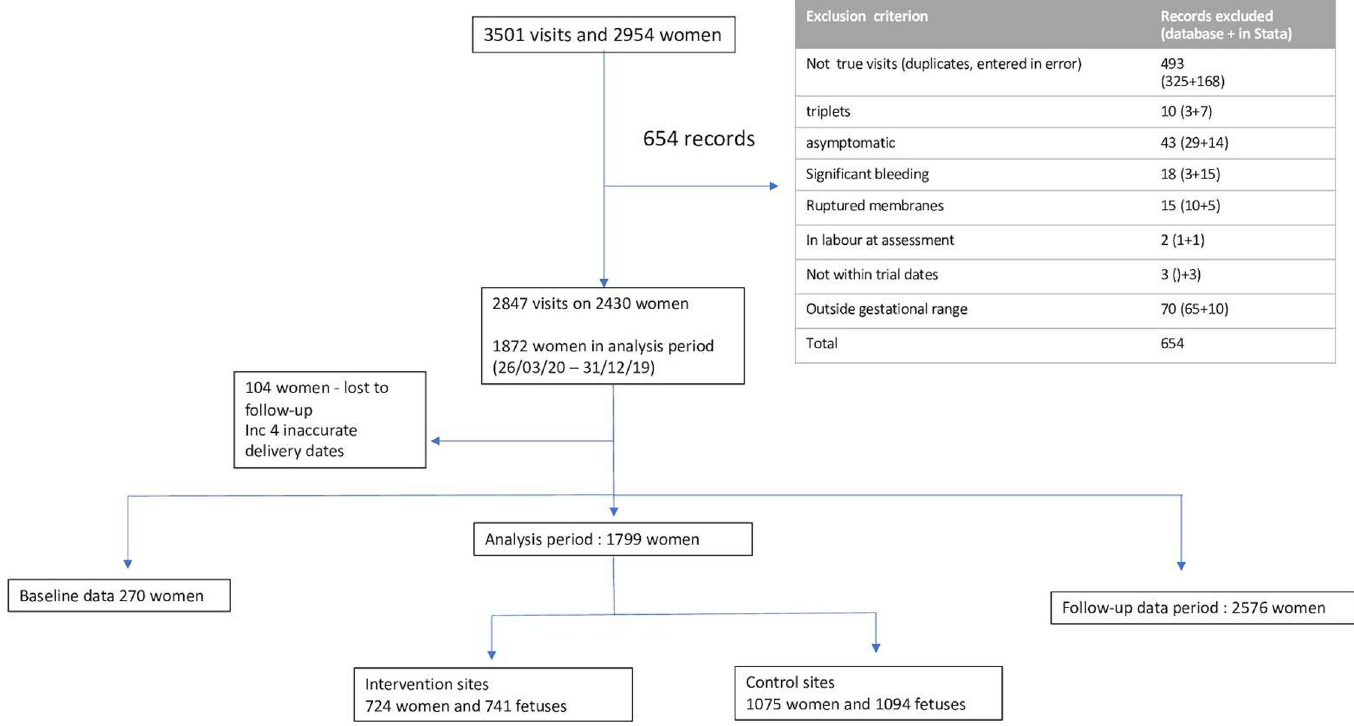
Fig 1. Flowchart to describe selection of women for EQUIPTT trial